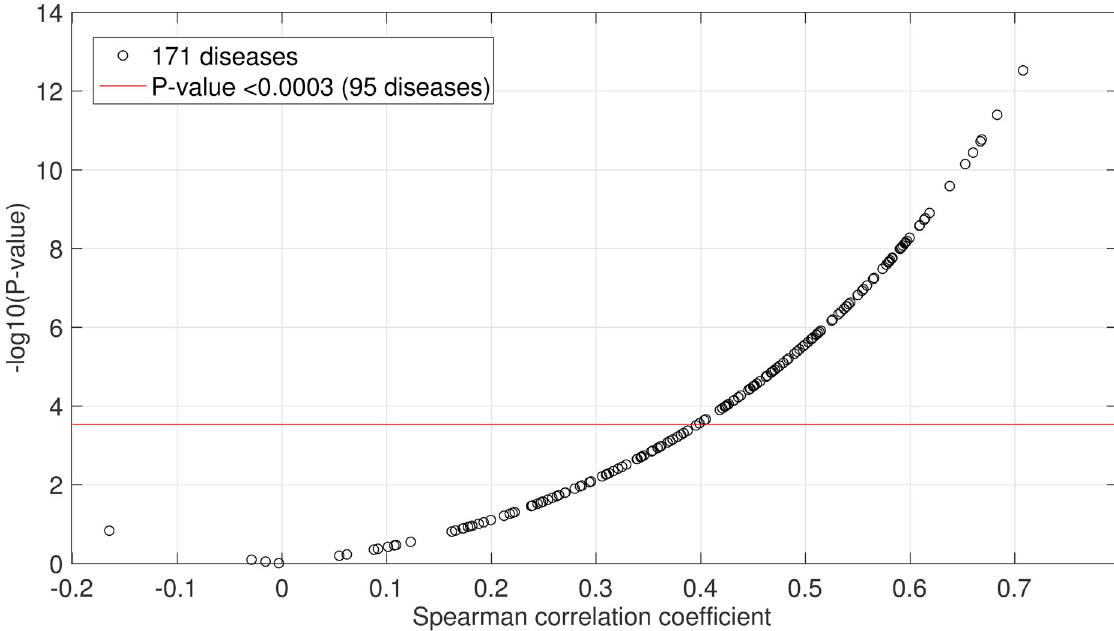
Fig 5. Predicted cytokine profiles for 171 well-studied diseases correlate with cytokine sampling in literature. The Spearman correlation coefficients between each disease’s NAAS and known literature sampling frequency are plotted against the P-values. Of the 171 diseases, we were able to predict the profiles for 95 diseases with p-value < 0.0003 (corrected cutoff by multiple testing), suggesting the accuracy of the predicted profiles.